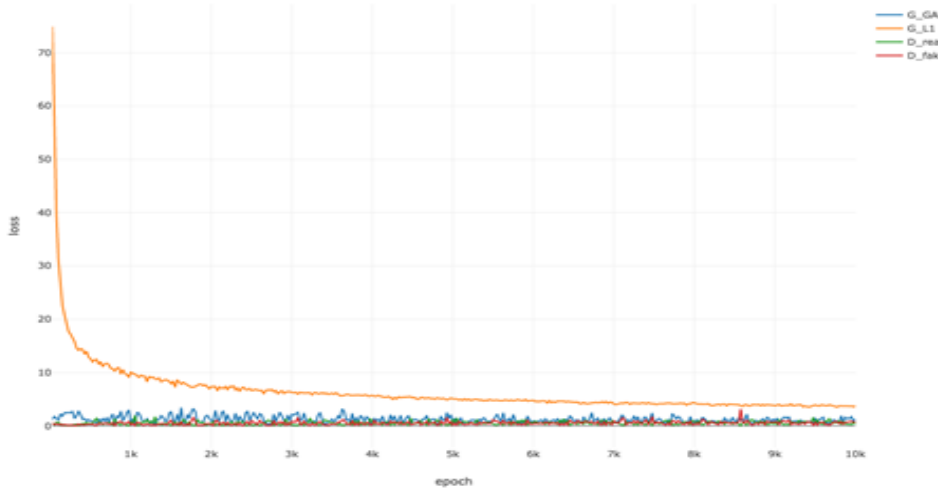
Figure 10. The loss function of the GANs-UNet, or pix2pix, trained on our data